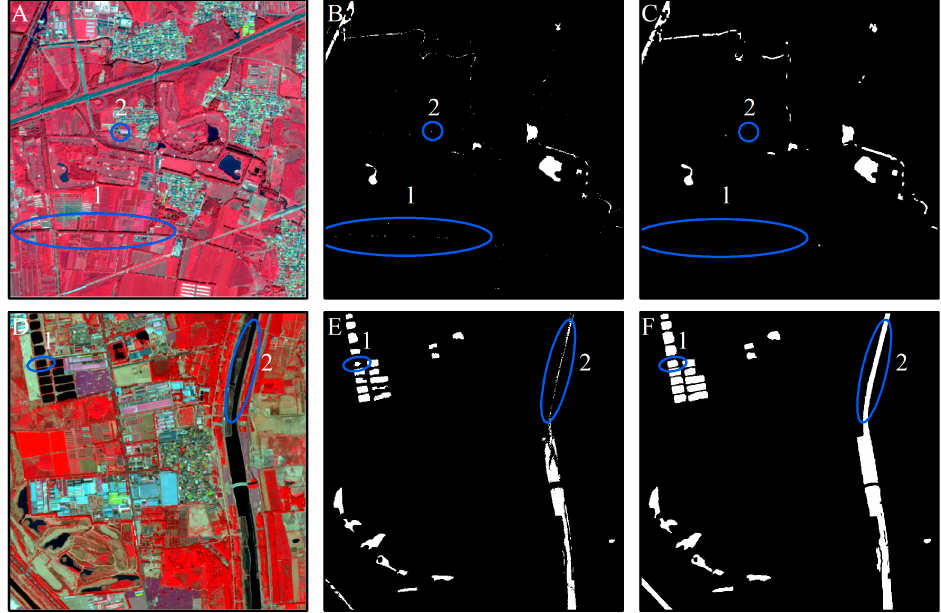
Figure 10. Comparison of the surface water extraction results before and after applying the object detection module. Column 1: ( A , D ), two false color sample images; Column 2: Pixel-level water extraction results in ( B , E ); Column 3: Water extraction results with the two-level pixel-object method ( C , F ). 1 and 2 are surface water sample objects.